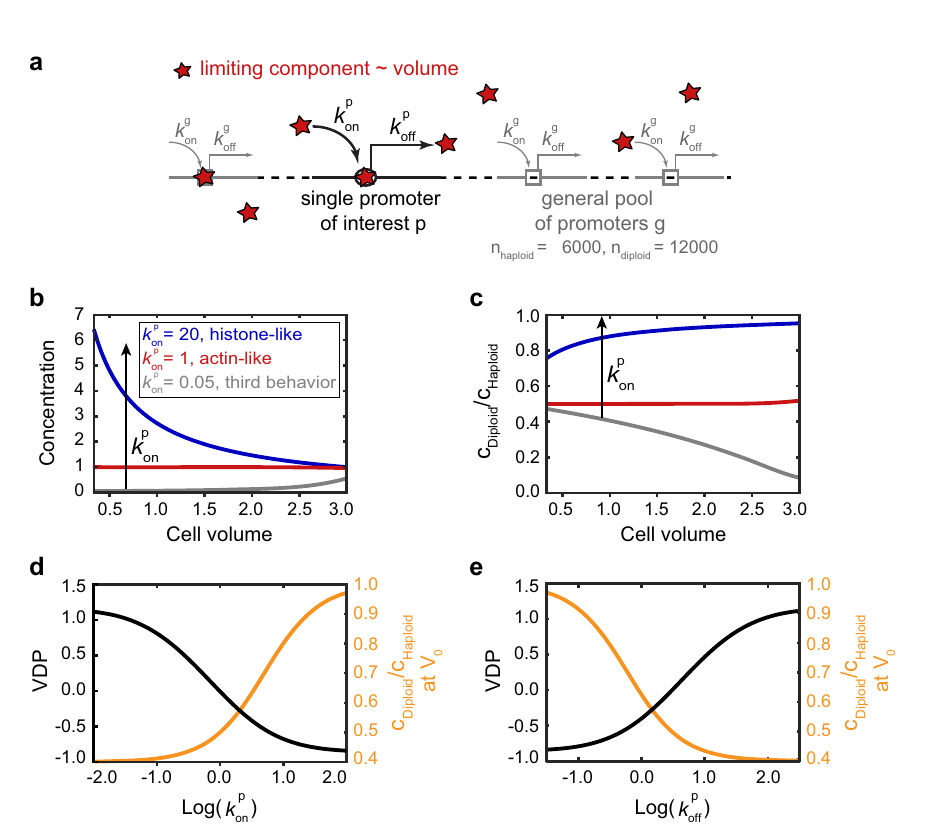
Fig. 4 Cell-cycle-dependence does not account for the cell-volume-dependence of expression from histone promoters. a – c mCitrine synthesis rate measured by live-cell fl uorescence microscopy during the fi rst cell cycle of new-born diploid cells, when expressed from an additional HTB1 ( a ), HTB2 ( b ), or HHF1 ( c ) promoter. Traces represent the mean of the moving averages over three frames of the single cell traces and are shown for the time span during which at least ten single cell traces were included in the average. All traces are aligned at the time of fi rst bud emergence ( t = 0). d Illustration of the smFISH experiments. Quasar ® -670-labeled probes were used to count mCitrine mRNA spots in diploid cells carrying an additional promoter driving mCitrine expression. DAPI-staining of nuclear DNA and bright- fi eld microscopy were used to classify cells as G1, S, or G2/M phase and to estimate cell volumes. Multiple images were taken per condition and at least two independent biological replicates were measured on different days. Example images show maximum intensity z-projections of diploid cells carrying an additional HTB1 promoter; contrast was adjusted for visualization. e – h mCitrine mRNA concentration in G1-, S-, or G2/M-phases, estimated as the number of mRNA spots detected with smFISH in the whole cell including the bud and divided by the cell volume, for diploid cells expressing mCitrine from an additional HTB1 ( e ), HTB2 ( f ), HHF1 ( g ), or ACT1 ( h ) promoter. Colored boxes highlight the 25- and 75-percentiles, whiskers extend to ± 2 : 7 σ of the distributions and colored crosses highlight outliers. Black, horizontal lines indicate the median between single cells for n G1 ¼ 158 ; n S ¼ 69 ; n G2M ¼ 57 ( e ), n G1 ¼ 77 ; n S ¼ 49 ; n G2M ¼ 25 ( f ), n G1 ¼ 113 ; n S ¼ 48 ; n G2M ¼ 21 ( g ), and n G1 ¼ 151 ; n S ¼ 48 ; n G2M ¼ 38 ( h ), with notches indicating the 95% con fi dence interval. Signi fi cances were tested using a two-tailed, two-sample t test at a con fi dence level α = 0.05, where applicable (between G1 and S-phase cells for ( f ), between all populations for ( g , h )), or a Kruskal – Wallis test at a con fi dence level α ¼ 0 : 05 otherwise; *** p G1vs S ¼ 1 : 0 (cid:3) 10 (cid:1) 11 ; *** p S vs G2M ¼ 1 : 2 (cid:3) 10 (cid:1) 9 ( e ), *** p G1vs S ¼ 8 : 0 (cid:3) 10 (cid:1) 21 ; *** p S vs G2M ¼ 6 : 5 (cid:3) 10 (cid:1) 7 ( f ), *** p G1vs S ¼ 3 : 5 (cid:3) 10 (cid:1) 16 ; *** p S vs G2M ¼ 5 : 4 (cid:3) 10 (cid:1) 4 ( g ). A diploid strain carrying no mCitrine allele was used as a control to test that smFISH signal is speci fi c (Supplementary Fig. 7h). i – l mCitrine mRNA concentration in S-phase cells, expressed from an additional ACT1 ( i ) or HTB1 ( j ), HTB2 ( k ), or HHF1 ( l ) promoter, shown as a function of cell volume in a double-logarithmic plot. Solid lines show linear fi ts to the double-logarithmic data, dashed lines represent the 95% con fi dence intervals of the fi t. Volume-dependence parameters (VDPs) were determined as the slope of the fi t, with respective standard error.